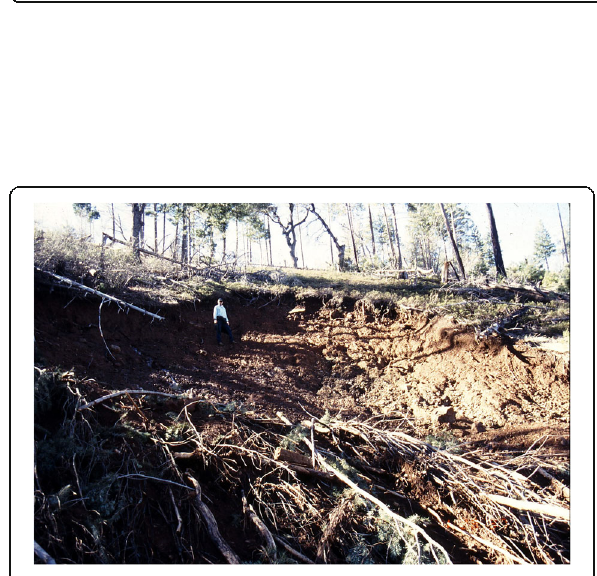
Fig. 3 The west debris flow initiation area of the Pilot Ridge debris flow. This was the larger of the two initiating debris slides. A 6-ft tall individual provides scale. Fallen fire-killed trees are seen around this area. Water was still flowing from the slide scarp to the lower left of the individual